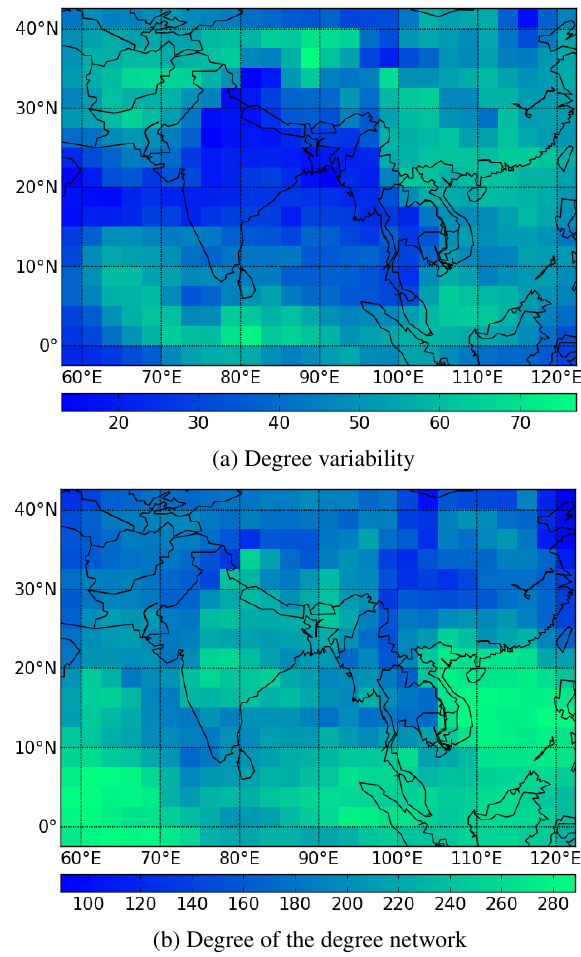
Figure 6. Mean degree variability (a) and degree of the degree Fig. 6: Mean degree variability (a) and degree of the degree variability (b) in the annual temperature anomaly networks (1970– variability (b) in the annual temperature anomaly networks Fig. 6: Mean degree variability (a) and degree of the degree (1970-2011). variability (b) in the annual temperature anomaly networks (1970-2011).